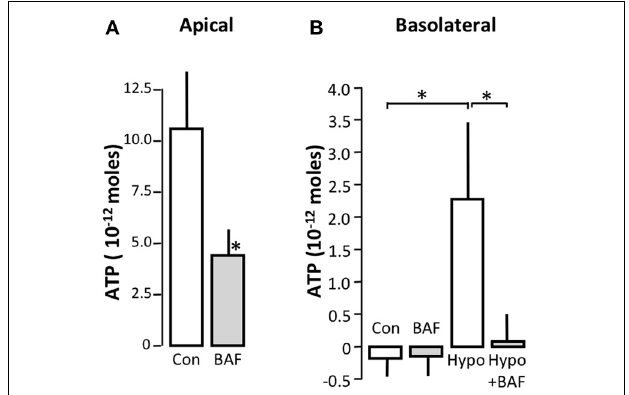
FIGURE 2 | The effect of bafilomycin A1 on the spontaneous and stimulated ATP release from MDCK cells. (A) Effect of bafilomycin A1 (1 μ M) on ATP release from the apical side under baseline conditions. (B) Effect of bafilomycin A1 on the ATP release from the basolateral side under baseline conditions and after reducing the osmolality to 50% of the original value on the basolateral side in the absence or presence of bafilomycin A1 (1 μ M). The values are shown as mean ± s.e.m. ( n = 8). The asterisks indicate statistical significance.